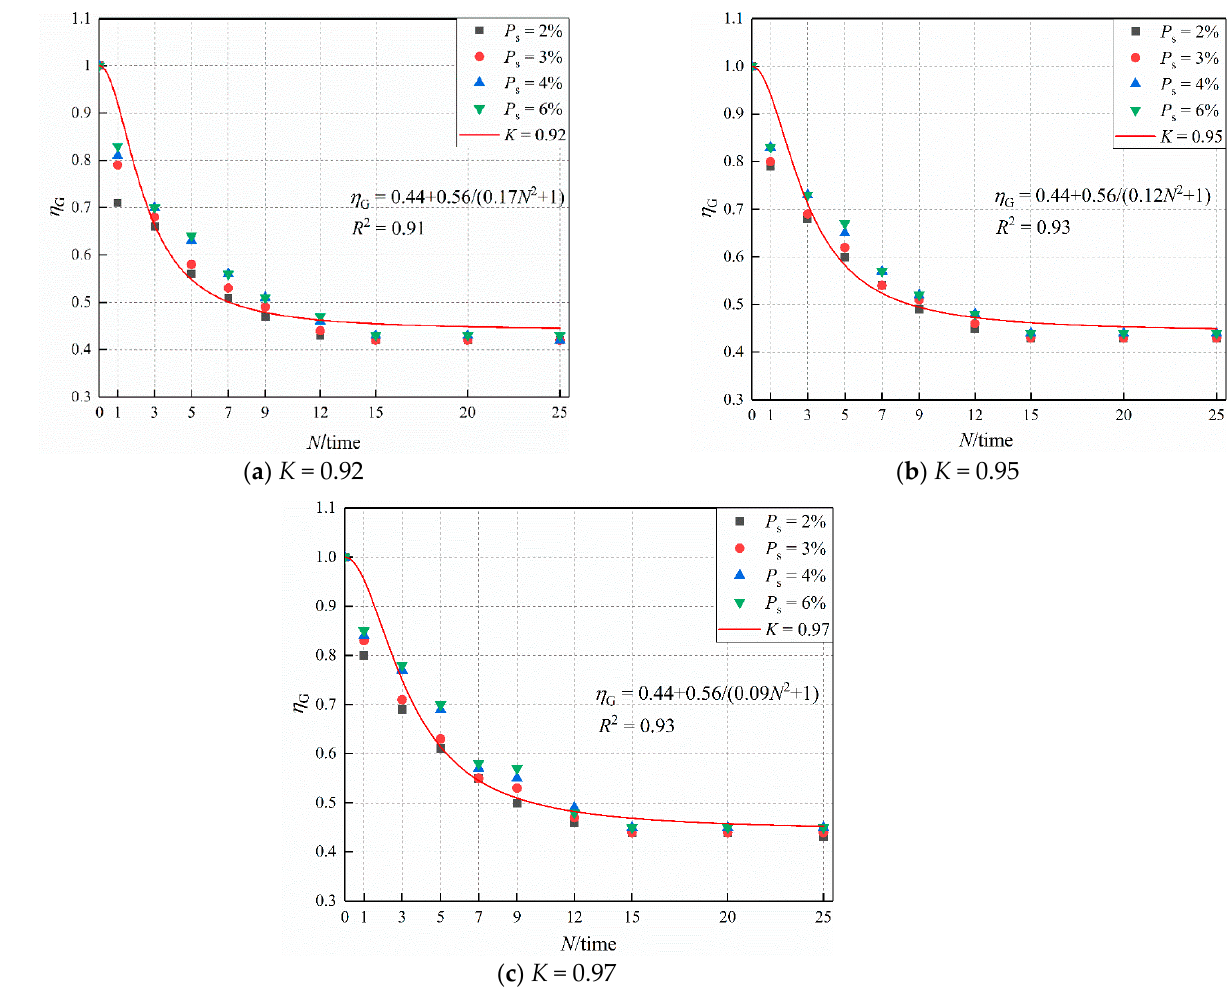
and N. Figure 2. The relationship between η G and N G